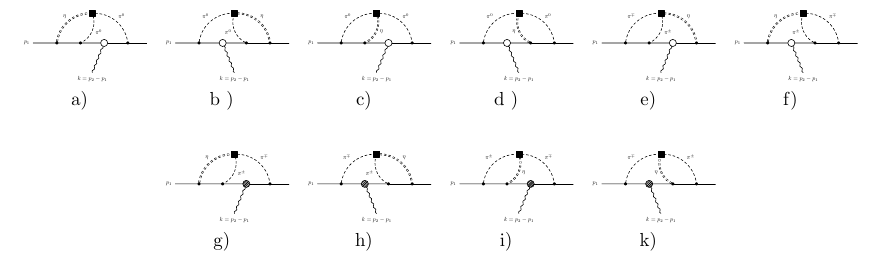
Figure 2. Diagrams contributing to the nEDM which are induced by the nonminimal electromagnetic couplings (anomalous magnetic moments) of nucleons. The solid square denotes the CP-violating η ( η (cid:48) ) ππ vertex. Empty and shaded circles correspond to the nonminimal electromagnetic couplings of neutron and proton,